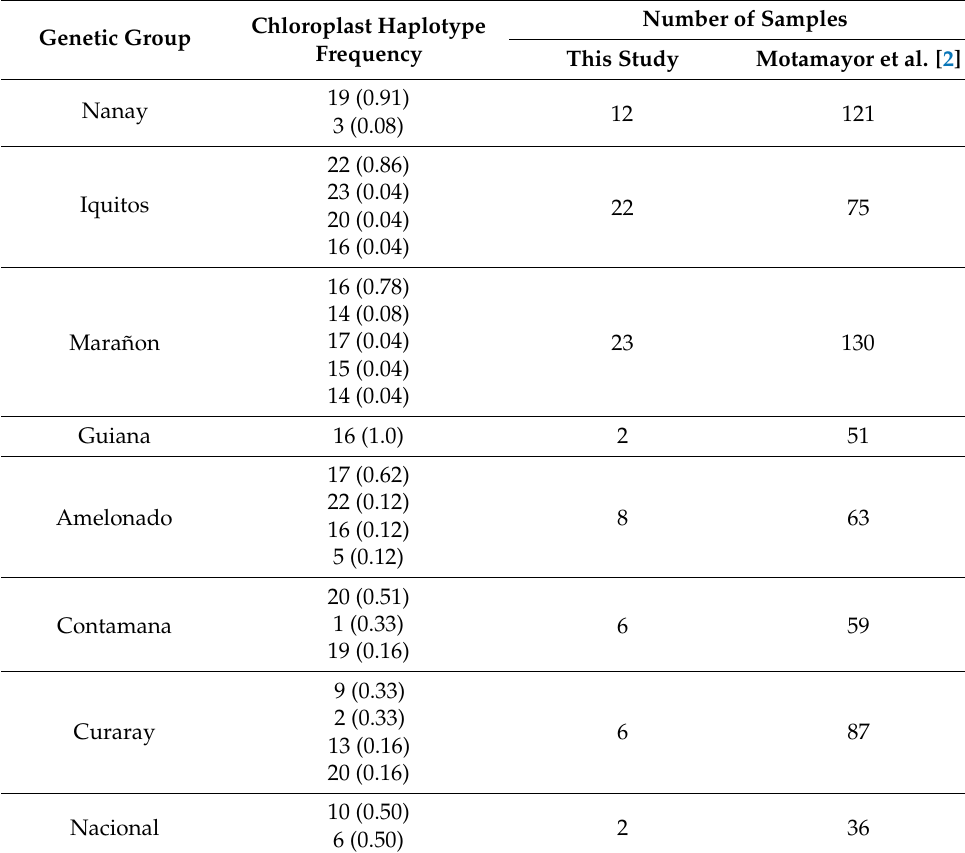
Table 3. Correspondence between nuclear and chloroplast DNA analyses in cacao ( Theobroma cacao L.). Cacao genetic groups, haplotype frequency and number of samples analyzed in this study and in Motamayor et al.